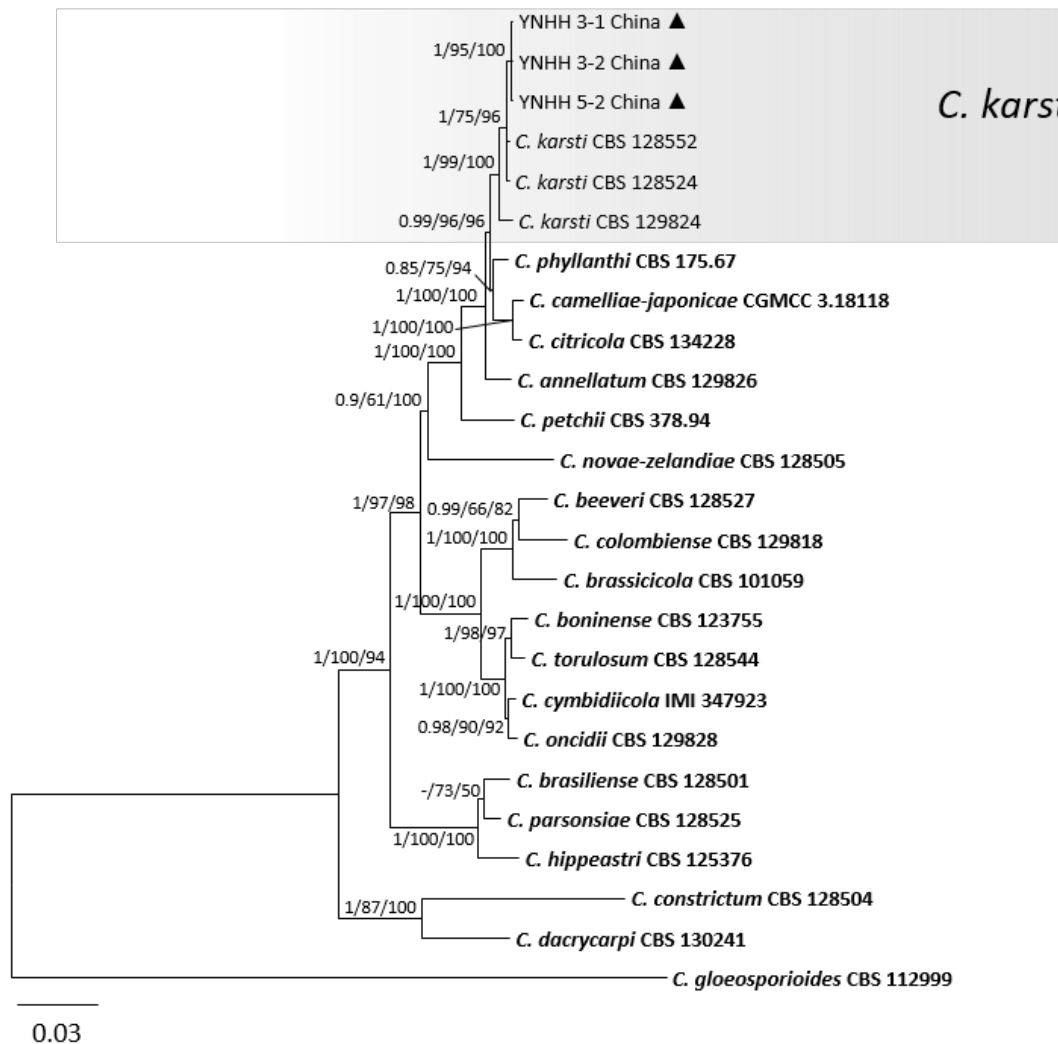
Figure 5. A Bayesian inference phylogenetic tree of 24 isolates in the C. boninense species complex. C. gloeosporioides (CBS 112999) was used as the outgroup. The tree was built using combined sequences of the ITS, GAPDH , CHS-1 , HIS3 , ACT , TUB2 and CAL . BI posterior probability values (BI ≥ 0.70), MP bootstrap support values (MP ≥ 50%), and RAxML bootstrap support values (ML ≥ 50%) were shown at the nodes (BI/MP/ML). Tree length = 1404, CI = 0.76, RI = 0.79, RC = 0.60, HI = 0.24. Ex-type strains are in bold. Circles indicate isolates from fruits, and triangles indicate isolates from leaves.